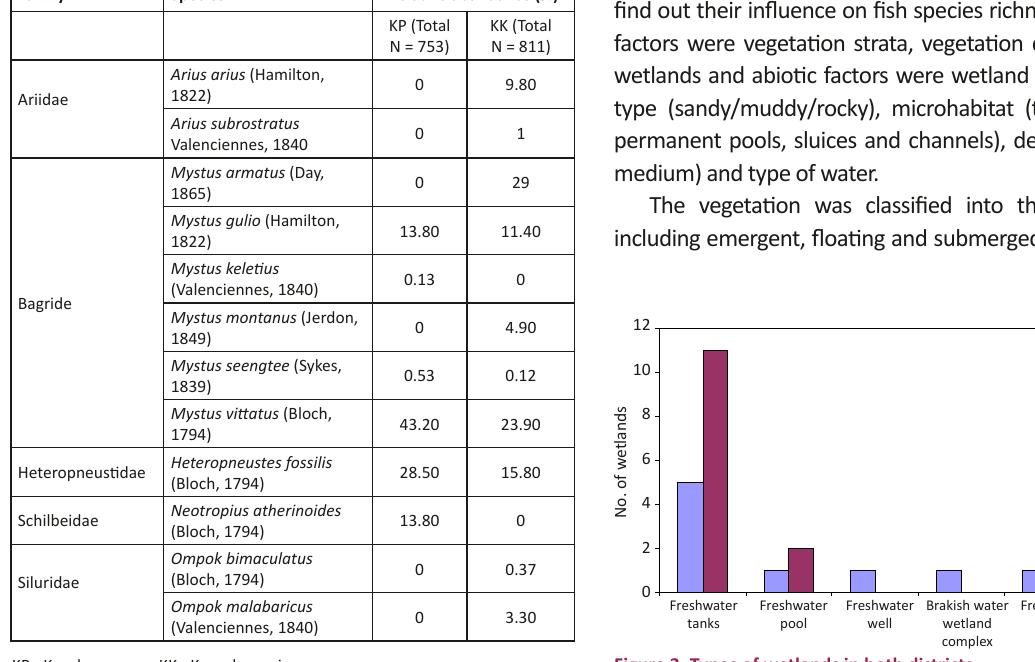
Figure 3. Types of wetlands in both